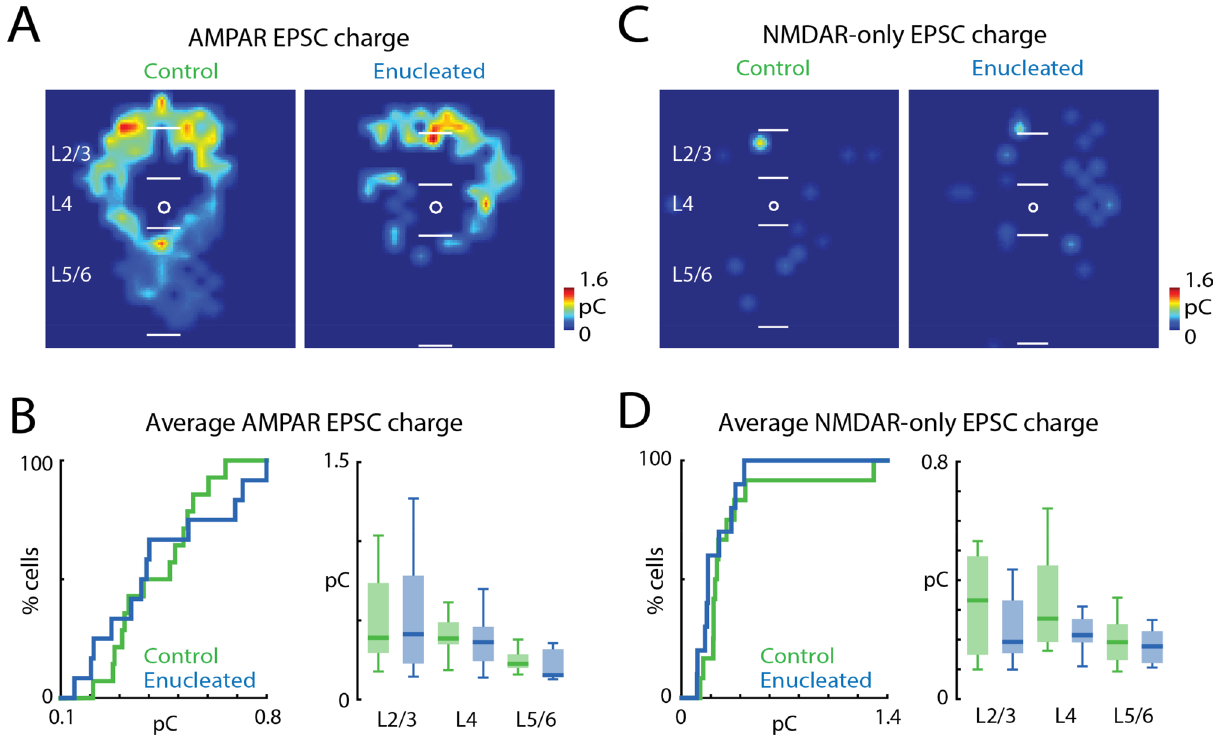
Figure 5. Strength of synaptic connections in Gad2 interneurons is not altered by enucleation. ( A ) Average EPSC charge of AMPAR-mediated inputs received by Gad2 interneurons in control and enucleated mice. ( B ) Quantification of AMPAR-mediated EPSC transferred charge. CDF of average transferred charge for each cell (left) and for inputs from each layer group (right). P > 0.05. ( C ) Average EPSC charge of NMDAR-only inputs received by Gad2 interneurons in control and enucleated mice. ( D ) CDF of average NMDAR-only transferred charge for each cell (left) and for inputs from each layer group (right). P > 0.05. For ( A ) and ( C ), white bars mark layer boundaries. The length of the white bars is 100 µm. Input locations are color-coded based on the average EPSC charge (pseudocolor scale to the lower right of each panel). For all panels: green, control group; blue, enucleation group. Statistics for ( B ) (left) and ( D ) (left) are in the main text. Statistics for ( B ) (right) and ( D ) (right) are in Table 5.